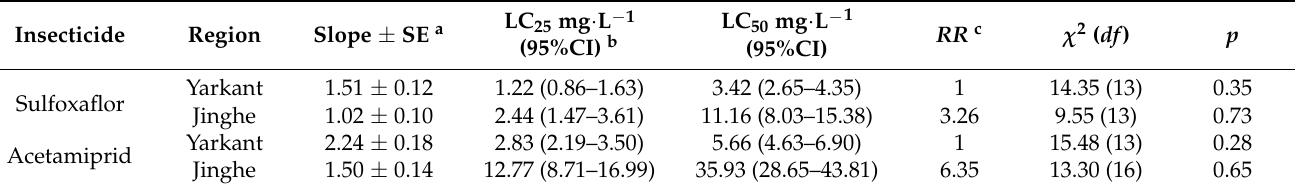
Table 1. Toxicity of sulfoxaflor and acetamiprid to Aphis gossypii in Yarkant and Jinghe. Insecticide Region Slope ± SE a